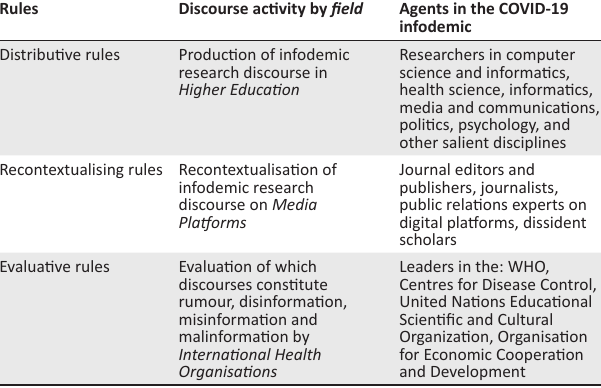
TABLE 2: Division of knowledge labour in the infodemic research agenda.